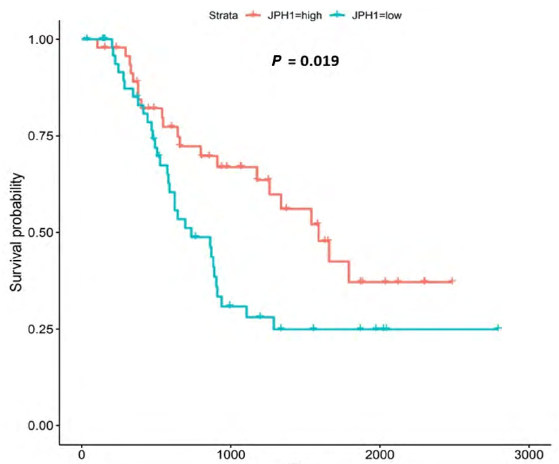
Figure 9. Kaplan-Meier survival plot for JPH1 . Details as described in Figure